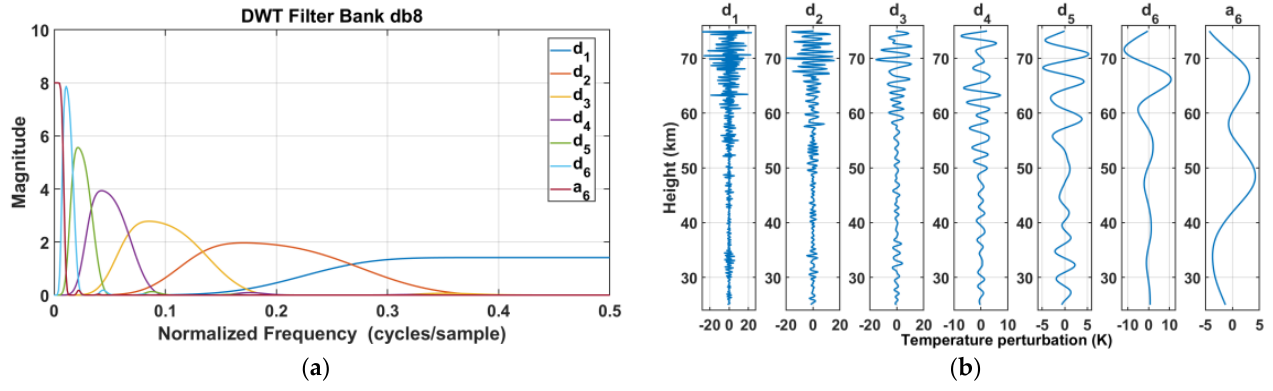
Figure 4. ( a ) The level 6 DWT filter bank with the db8 wavelet. The normalized frequency of 0.5 is twice the vertical resolution, i.e., 300 m for lidar profiles; ( b ) DWT decomposition of the 15 min temperature perturbation profile at 1535 UTC (1935 LST) on 9 October 2017.